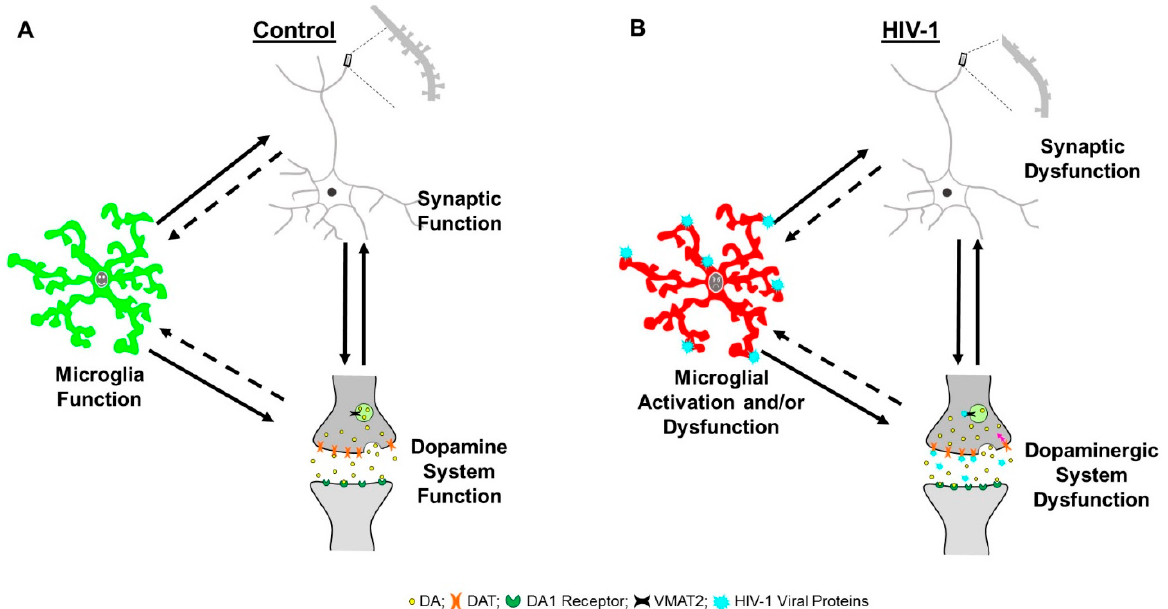
Figure 4. Proposed (potentially) cyclical model of the interrelationship between microglia, and synaptic and dopaminergic system function. ( A ) Under homeostatic conditions, microglia influence both the dopamine (DA) system and synaptic maintenance. Furthermore, synaptic and dopaminergic system functions exhibit a bidirectional relationship. To date, it is unknown whether the relationships between microglia and synaptic function or microglia and DA system function are bidirectional, as indicated via the dashed lines. ( B ) Chronic exposure to HIV-1 viral proteins induces activation, dysfunction and/or senescence of microglia, and microglial alterations which may underlie the prominent low DA levels and/or synaptic dysfunction observed in the post-cART era. DA: dopamine; DAT: dopamine transporter; DA1 Receptor: dopamine 1 receptor; VMAT2: vesicular monoamine transporter 2.